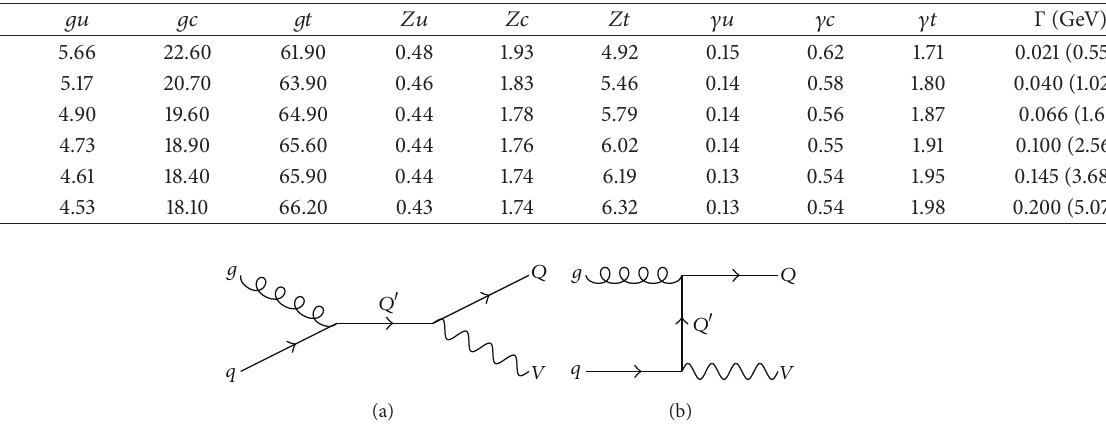
Figure 1: Diagrams for the subprocess 𝑔𝑞 → 𝑉𝑄 with anomalous vertices 𝑄 󸀠 𝑞𝑉 and 𝑄 󸀠 𝑄𝑉 (where 𝑄 󸀠 can be the new heavy quark 𝑏 󸀠 or 𝑡 󸀠 depending on the type of light ( 𝑞 ) or heavy (𝑄 ≡ 𝑡,𝑏) quarks, resp.).